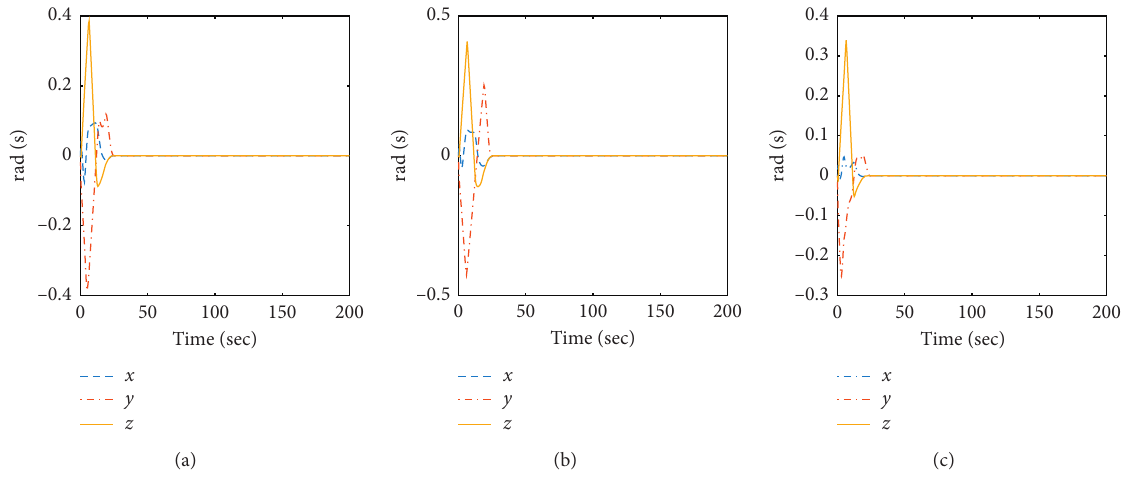
Figure 4: The curves of the relative angular velocity error. (a) Sat1. (b) Sat2. (c) Sat3.